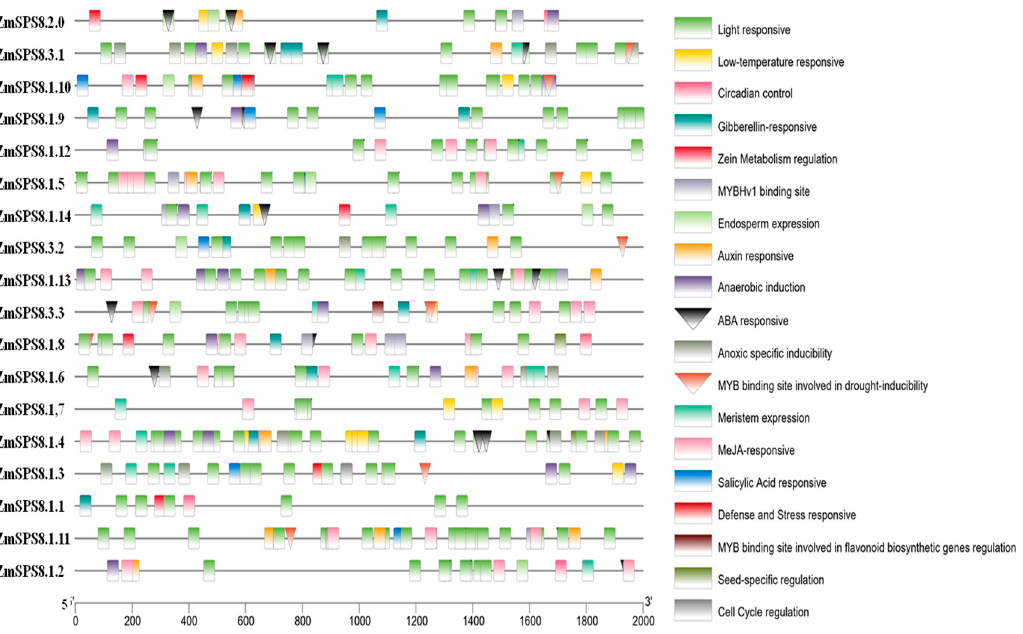
Figure 4. Putative regulatory cis-elements in maize serine peptidase S8 family gene promoters. Boxes of different colors represent different cis-elements and the position of drought stress-related cis-acting elements. in all genes is indicated by the inverted triangle.